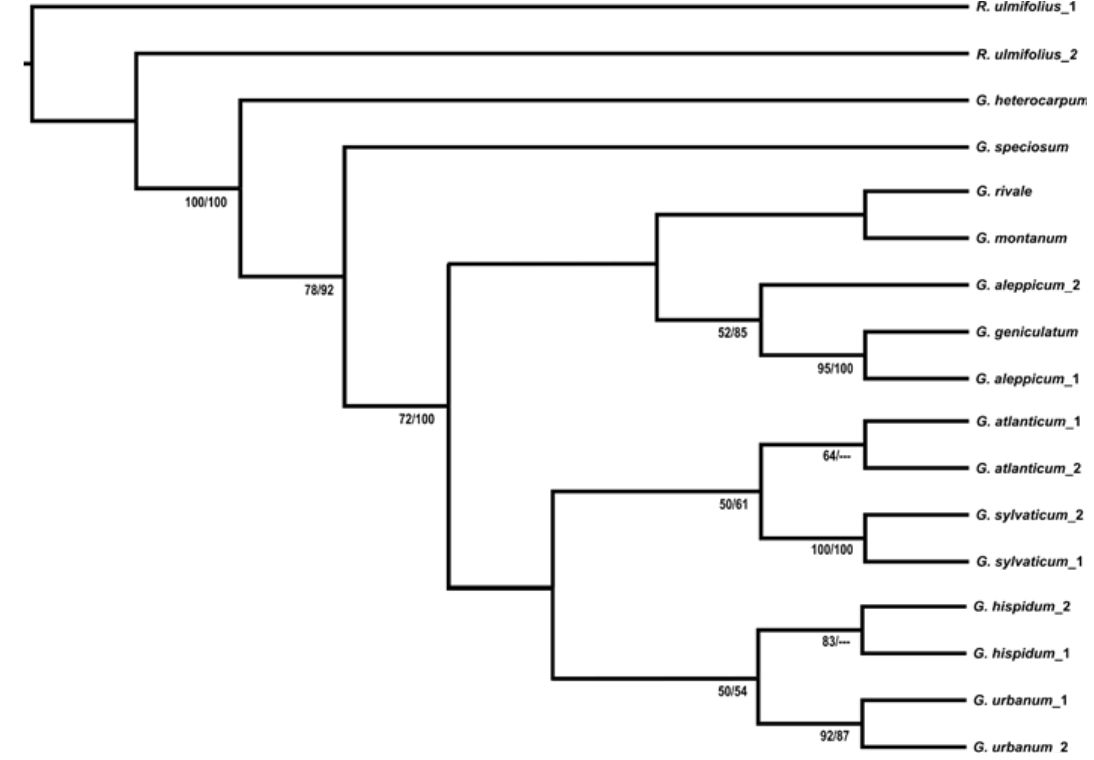
Figure 3. Maximum likelihood phylogenetic tree inferred for a sampling of select species of Geum . Bootstrap values (Bs) followed by Bayesian posterior probabilities (PP) above 50% are given below the branches. The tree was rooted with Rubus ulmifolius as